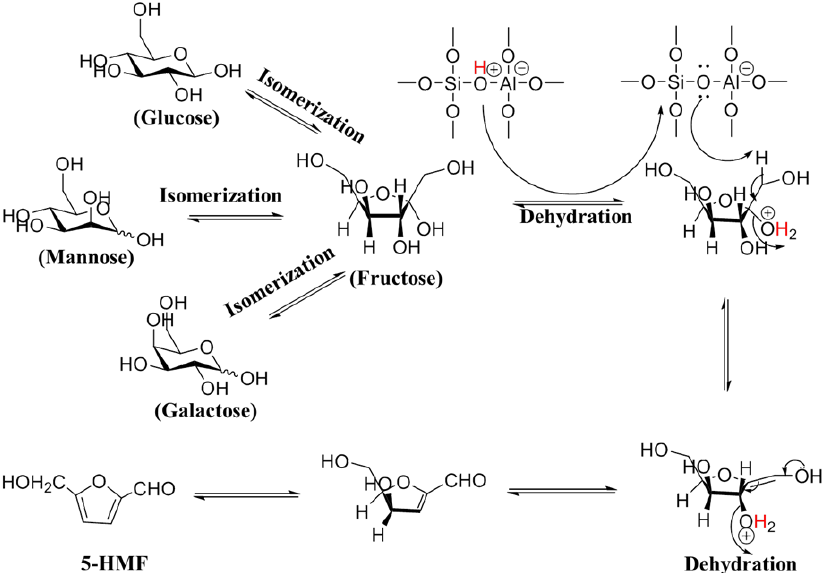
Scheme 2. Reaction pathway for the synthesis of 5-HMF over PHMS−2